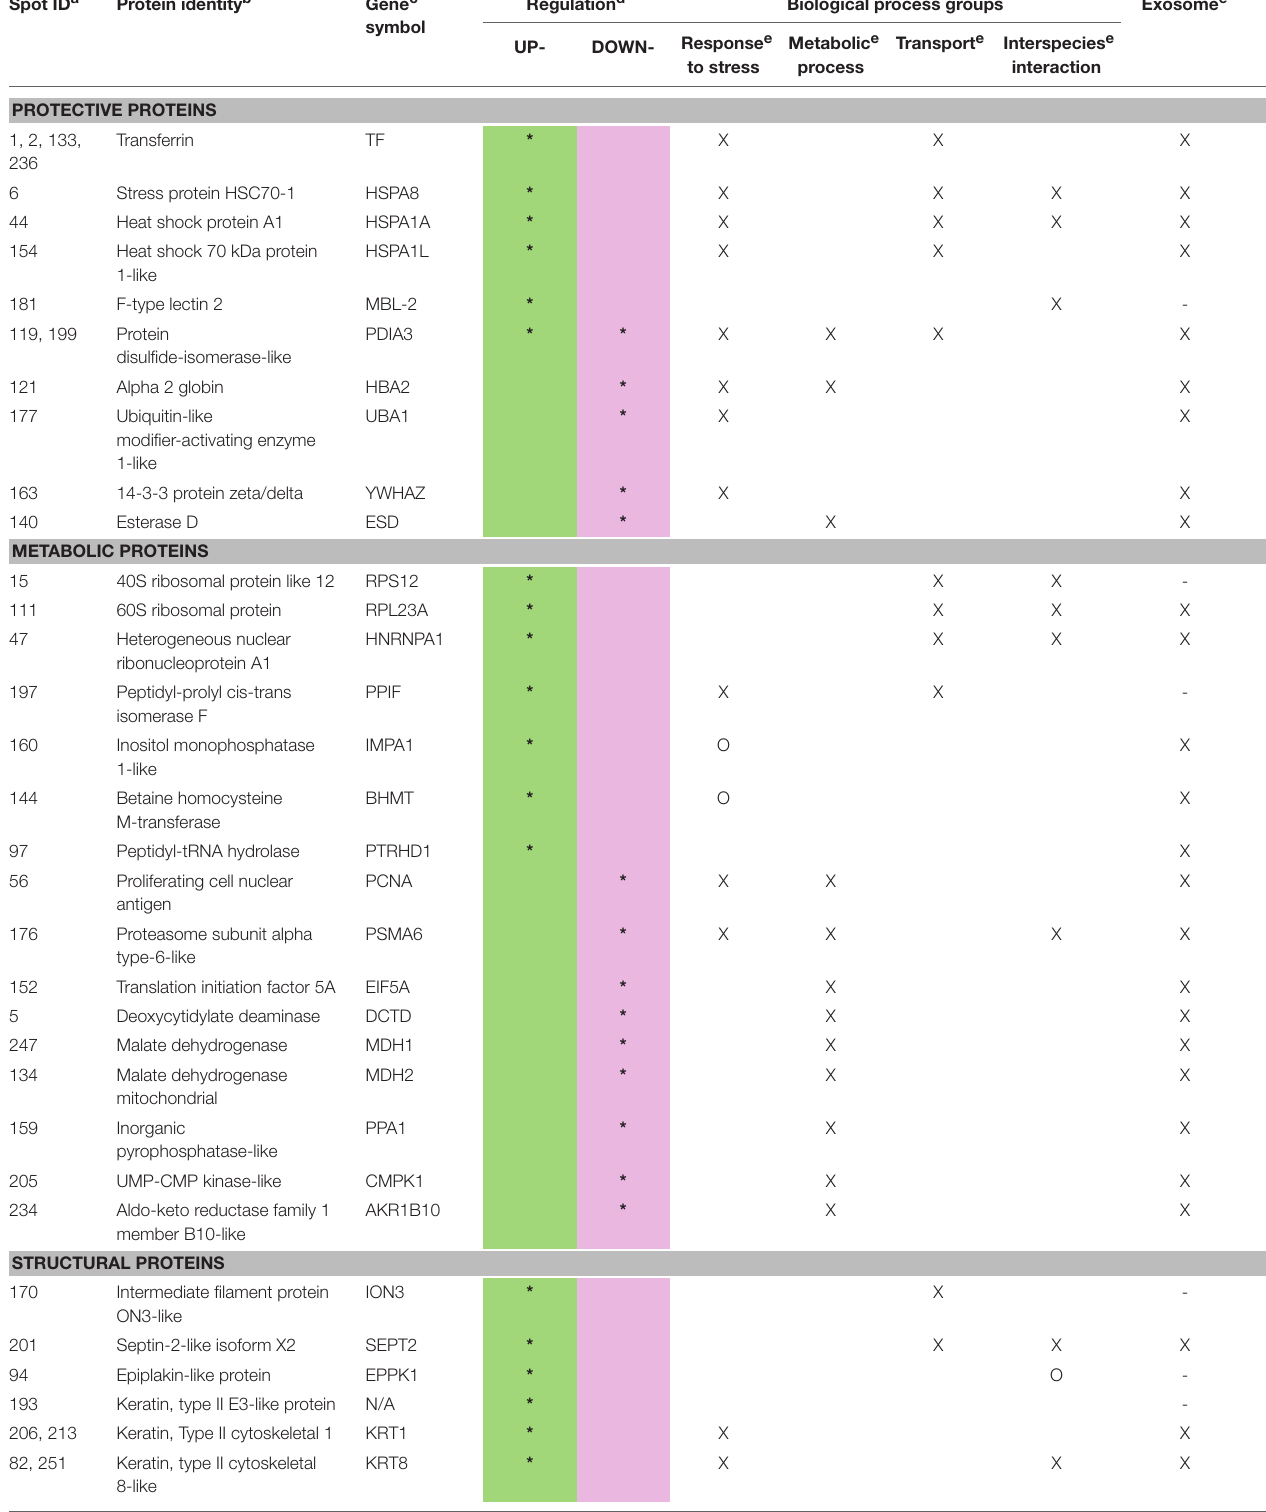
Regulation d Biological process groups Exosome e symbol Response e Metabolic e Transport e Interspecies e interactionUP- DOWN- to stress process